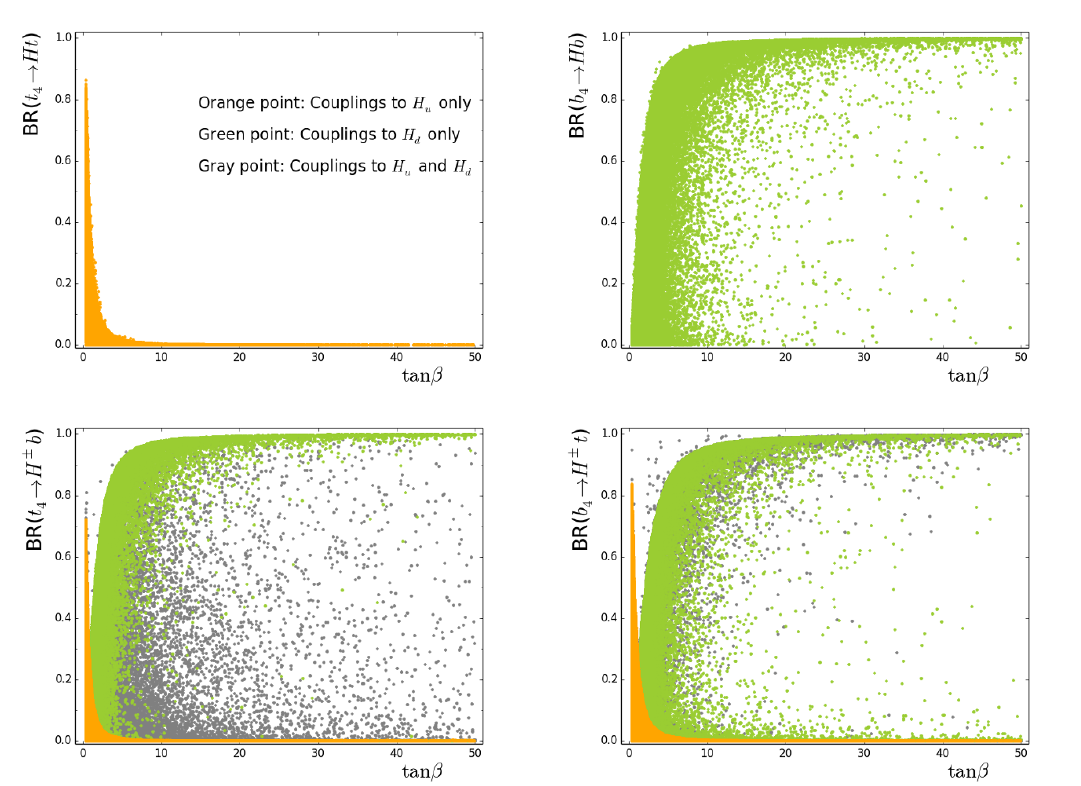
Figure 1 . Allowed branching ratios of t 4 and b 4 into heavy charged and neutral Higgses. In all panels, orange (green) points correspond to couplings to H u ( H d ) only; gray points are the additional possibilities allowed by a full parameter space